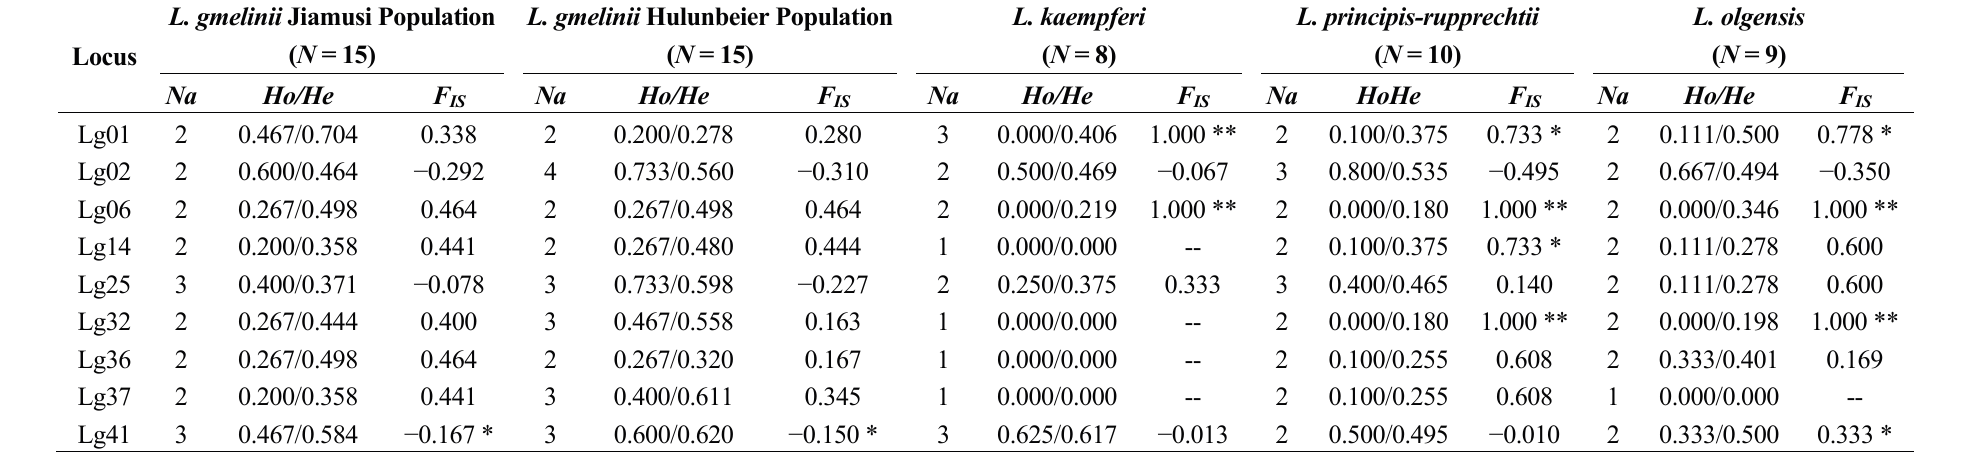
Table 2. EST-SSR Genetic diversity for two populations of L. gmelinii and its cross-species transferability for L. kaempferi , L. principis-rupprechtii and L. olgensis